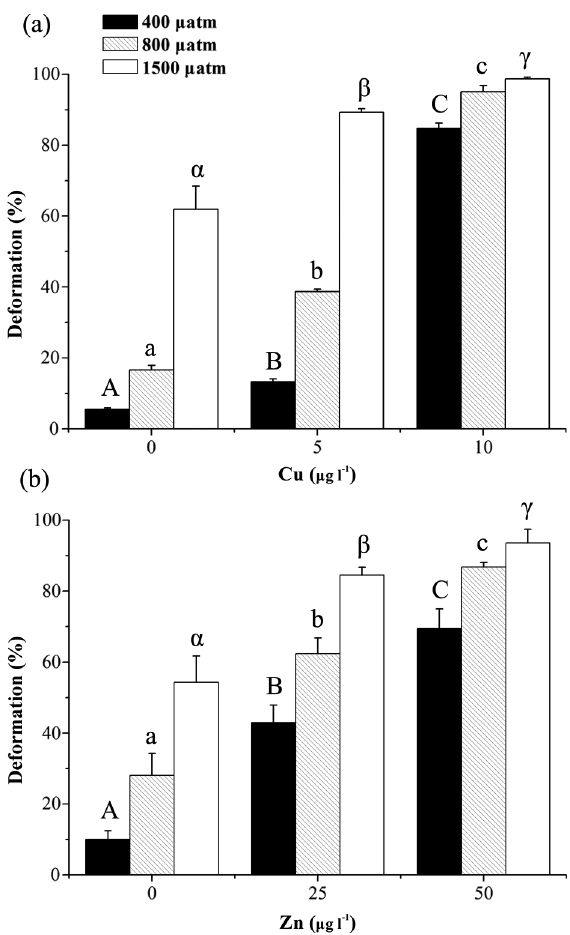
Fig. 5. Deformation rate (mean + SD; n = 4) of Crassostrea Fig. 6. Deformation rate (mean + SD; n = 4) of Haliotis discus angulata larvae 24 h post fertilization at 3 pCO 2 levels with hannai larvae 24 h post fertilization at 3 pCO 2 levels with the the addition of (a) Cu or (b) Zn. Different upper- and lower- addition of (a) Cu or (b) Zn. Different upper- and lowercase case letters represent significant differences between trace letters represent significant differences between trace metal metal concentrations at the same pCO 2 level (p < 0.05). A concentrations at the same pCO 2 level (p < 0.05). A line line above columns indicates no significant difference be- above columns indicates no significant difference between tween pCO 2 levels at the same trace metal concentration. pCO 2 levels at the same trace metal concentration. Columns Columns not connected by lines are significantly different not connected by lines are significantly different from each from each other (p < 0.05) other (p <